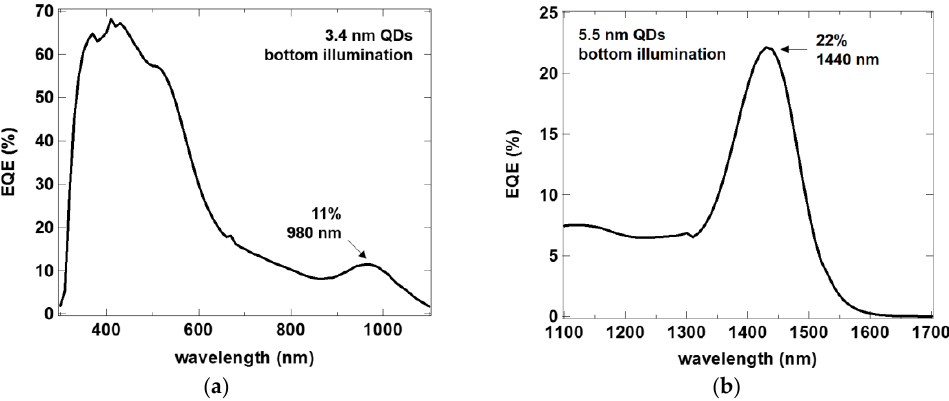
Figure 7. External quantum efficiency of QDPD devices with 3.4 nm ( a ) and 5.5 nm ( b ) quantum dots.